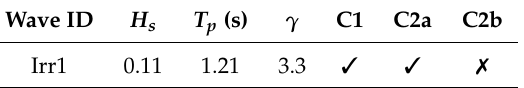
Table 7. Irregular wave tests schedule.